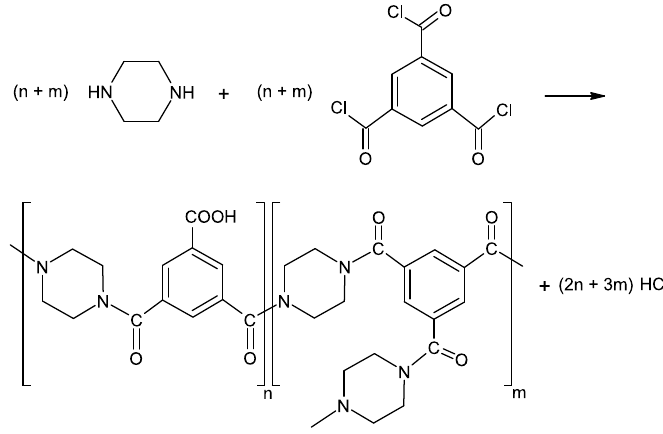
Figure 2. Reaction scheme of polyamide formation from piperazine (PIP) and trimesoylchloride (TMC) monomers; adapted from [38,39].